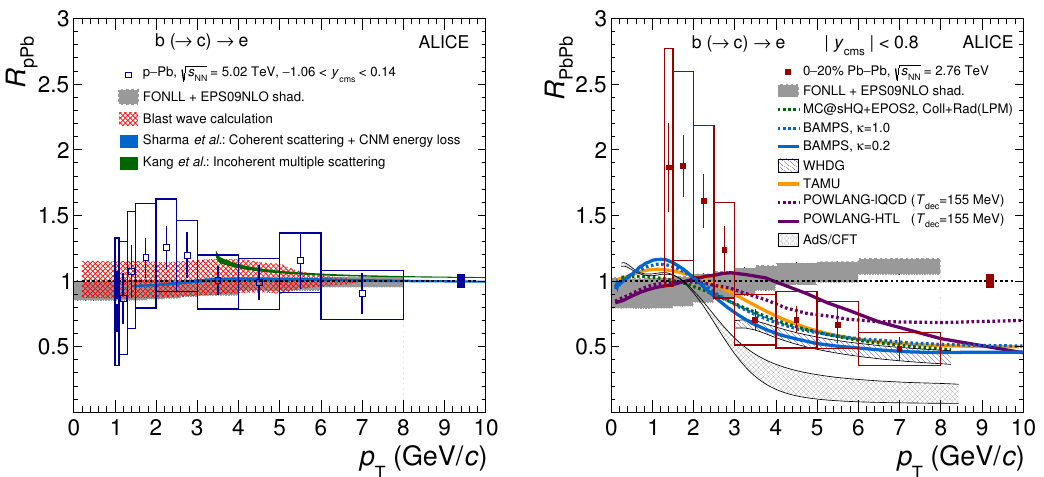
Figure 7 . Nuclear modi(cid:12)cation factors R pPb (left) and R PbPb (right) of electrons from beauty- hadron decays in comparison with di(cid:11)erent theoretical predictions [17, 18, 29{31, 57, 84, 90{97], see text for details. The vertical bars represent the statistical uncertainties, while the boxes indicate the systematic uncertainties. The normalisation uncertainty, common to all points, is shown as a (cid:12)lled box at high p T for both collision